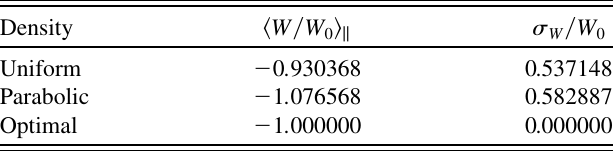
TABLE III. Comparison of CSR-induced energy change and rms CSR-induced energy spread for densities with matched total bunch length.